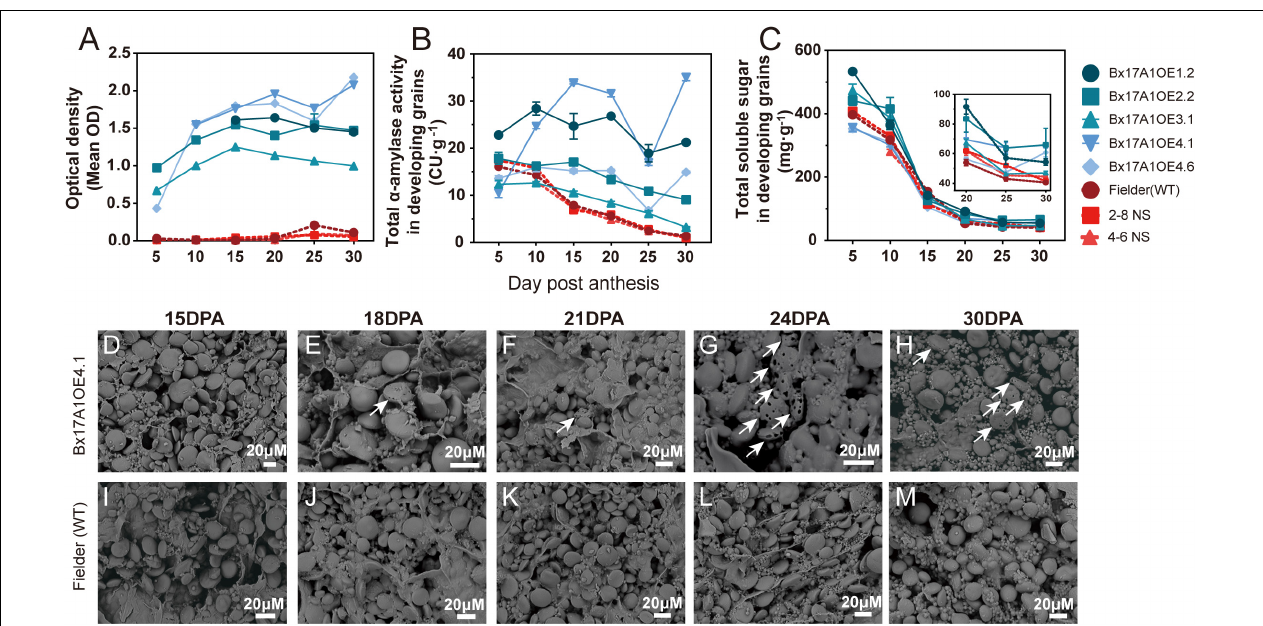
FIGURE 3 | Effect of TaAMY1 overexpression on grain composition and starch morphology during development. TaAMY1 protein content expressed by optical density (A) and total α -amylase activity expressed in Ceralpha Units (CU) of per gramme of tissue (B) , and total soluble sugar expressed in mg.g tissue – 1 (C) during grain development. Scanning electron micrographs (SEM) of representative grain cross sections from Bx17A1OE4.1 (D–H) and Fielder (wild type, WT) (I–M) during key grain development stage. White arrows indicated starch degraded by